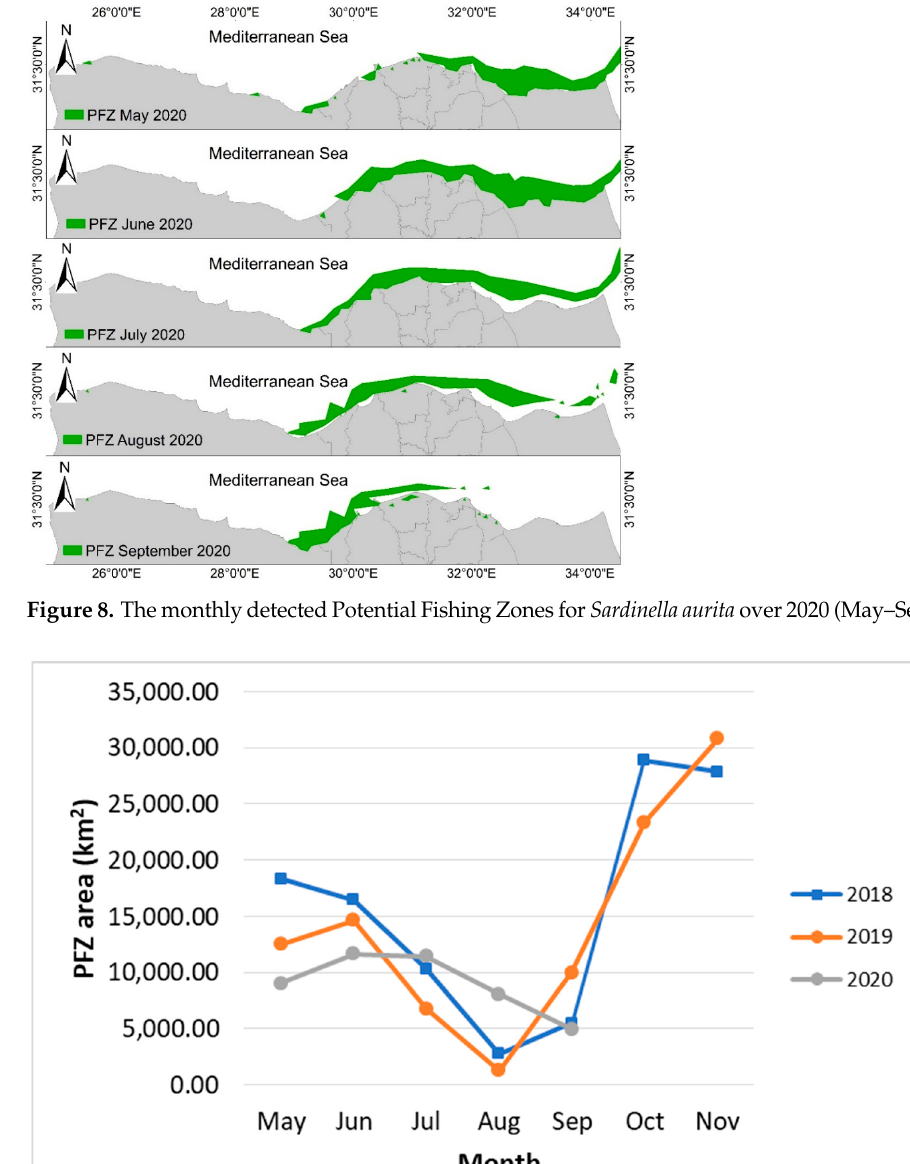
Figure 9. Monthly variations in PFZ area for Sardinella aurita during 2018–2020.